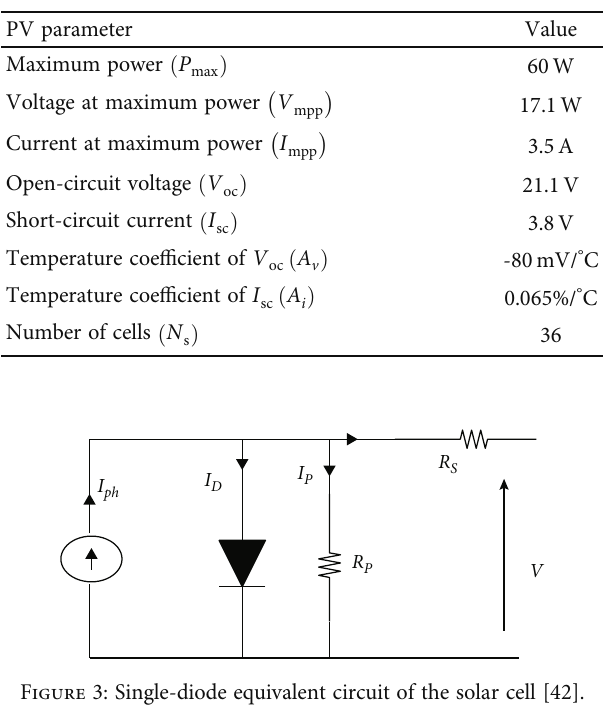
Figure 2: Photovoltaic system made up of PV module, DC/DC Converter, load, and MPPT controller [41]. Table 1: Characteristics of the MSX-60 W solar panel at STC from datasheet.